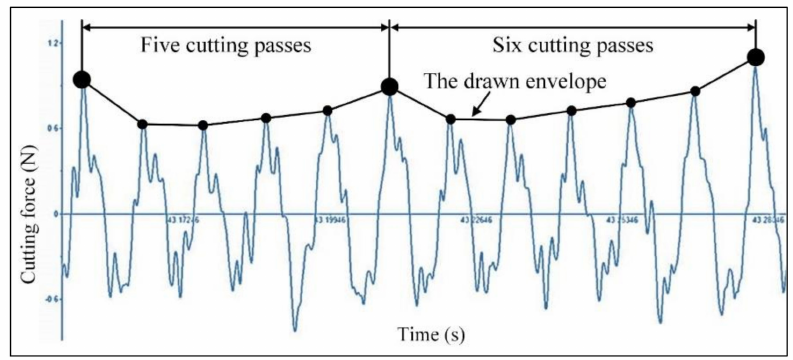
Figure 6. The cutting force signal waveform at f z = 0.09 µ m ( a p = 5 µ m, n = 16,000